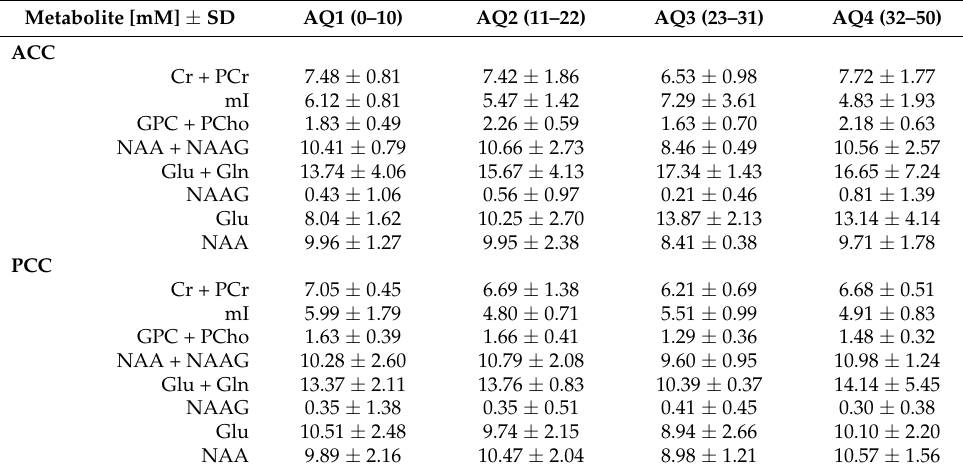
Note: creatine + phosphocreatine (Cr + PCr); myoinositol (mI); glycerophosphocholine + phosphocholine (GPC + PCho); N -Acetyl-aspartate + N -Acetyl aspartyl glutamate (NAA + NAAG); Glutamate + glutamine (Glu + Gln) or Glx.